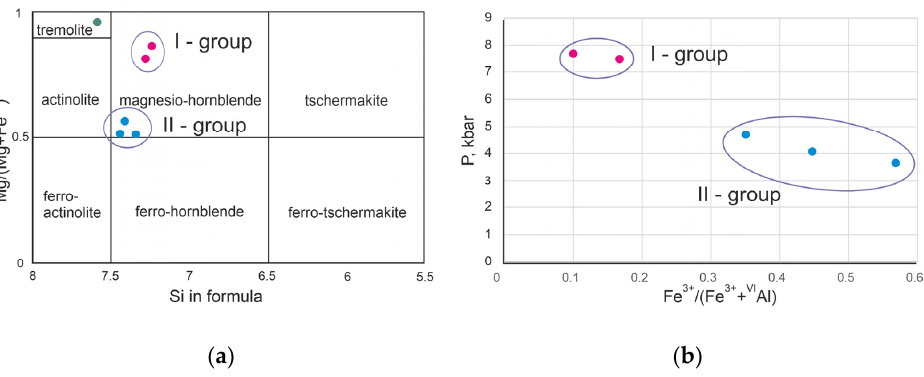
Figure 9. ( a ) Classification diagram of amphiboles [64], ( b ) a plot of Fe 3+ /(Fe 3+ + VI Al) vs. P, kbar for amphiboles from melt and crystalline inclusions in PGM.